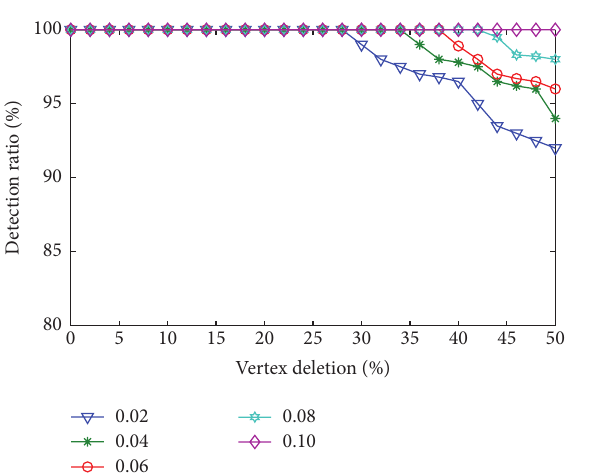
Figure 4: Resistance to simplification.